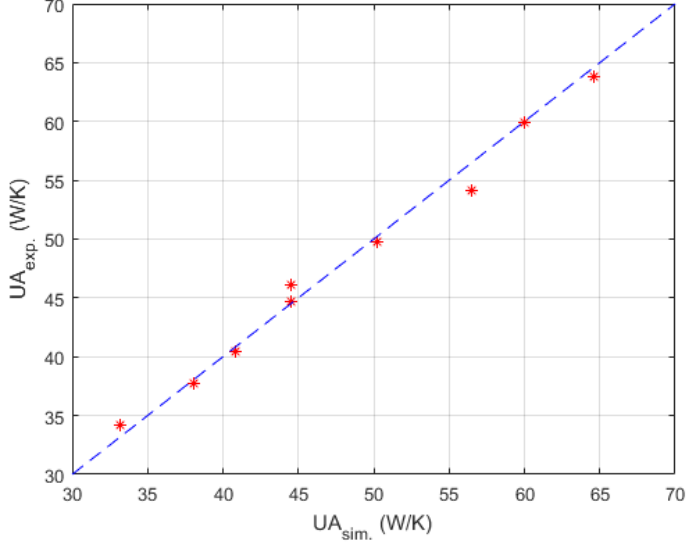
Figure 8. Parity plot of UA (the overall heat transfer coe ffi cient ( U ) and the overall heat transfer area ( A )) calculated from experimental data against those given by Equation (21) using the searched values of α , β , and R f . Table 2. Experimental conditions for simulating the heat exchange experiments [9]. Utility Stream Process Experiment No.